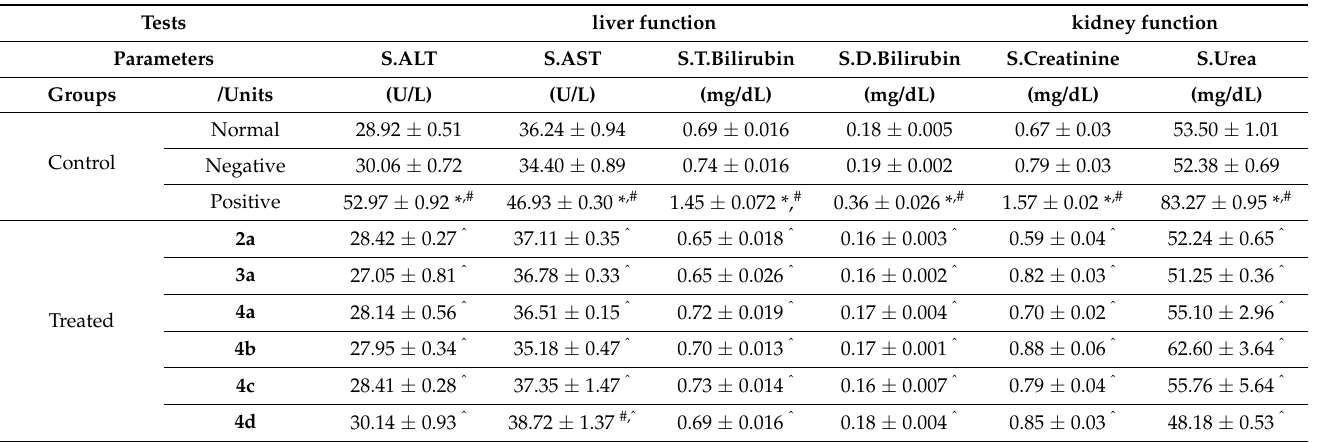
Table 2. Effects of the acute oral toxicity study of isatin derivatives ( 2a, 3a, 4a, and 4b, 4d, and 4c ) on liver and kidney function tests of